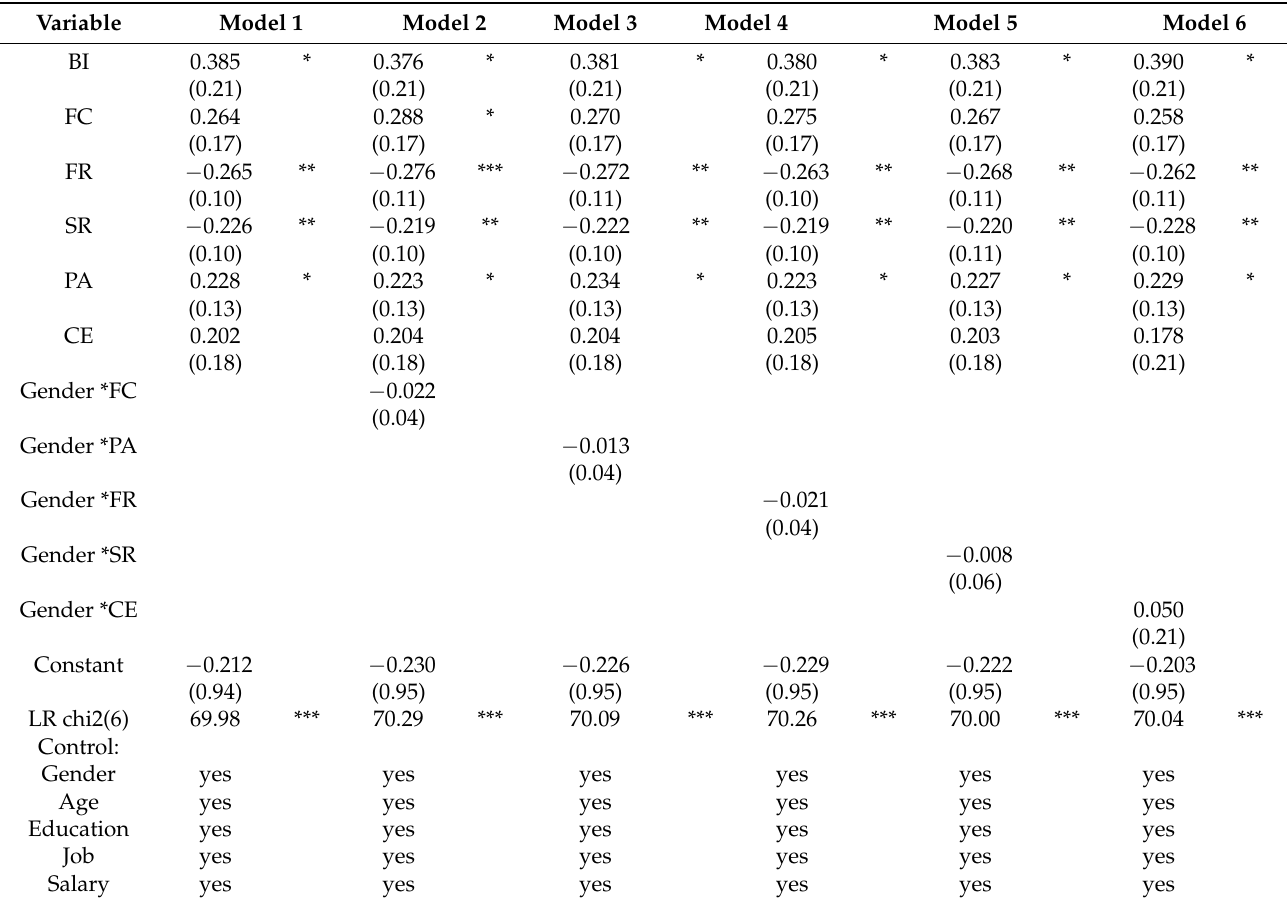
Table 6. Maximum likelihood estimates of the probit